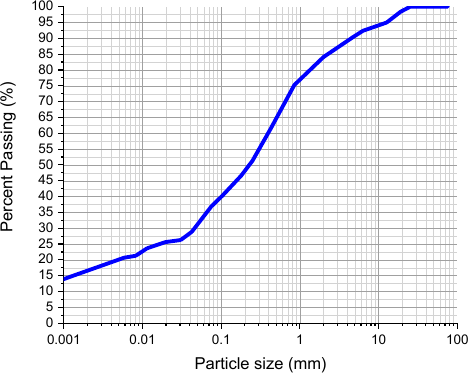
Figure 1. Particle size distribution of the soil, according to the results of the sedimentation test. Table 1. Particle size distribution and Atterberg limits of the soil used.